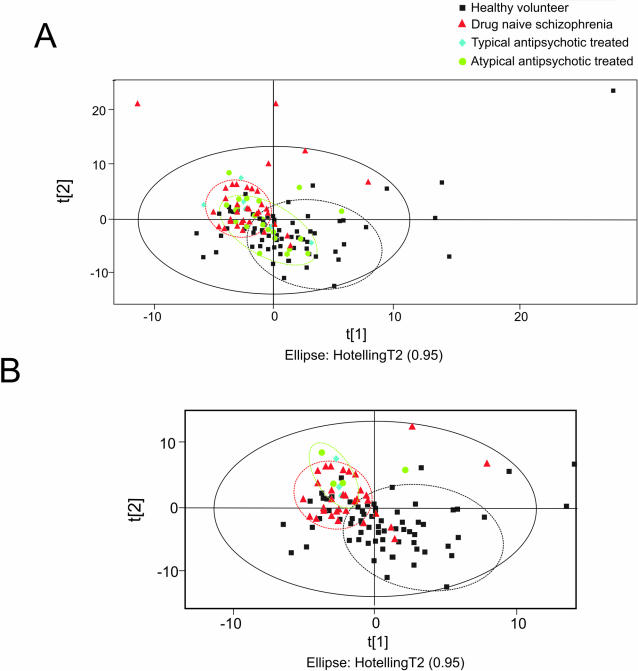
Effects of “Typical” and “Atypical” Medication on CSF Metabolic Profiles in Patients with First-Onset Schizophrenia(A) Spectra from 28 CSF samples from patients with first-onset schizophrenia minimally treated (<9 d, see text for details) with either typical (n = 6, blue diamonds) or atypical (n = 22, green circles) antipsychotic medications were compared to first onset, drug naïve patients (red triangles) and healthy volunteers (black squares) using PLS-DA. The PLS-DA scores plots show that atypical antipsychotic drug treatment resulted in a shift of approximately 50% of patients with schizophrenia towards the cluster of healthy controls.(B) The same PLS-DA scores plot as (A) except that only minimally treated patients (from both drug groups) with more than one psychotic episode prior to antipsychotic treatment are shown. Note that none of these patients shifted towards the healthy control cluster.